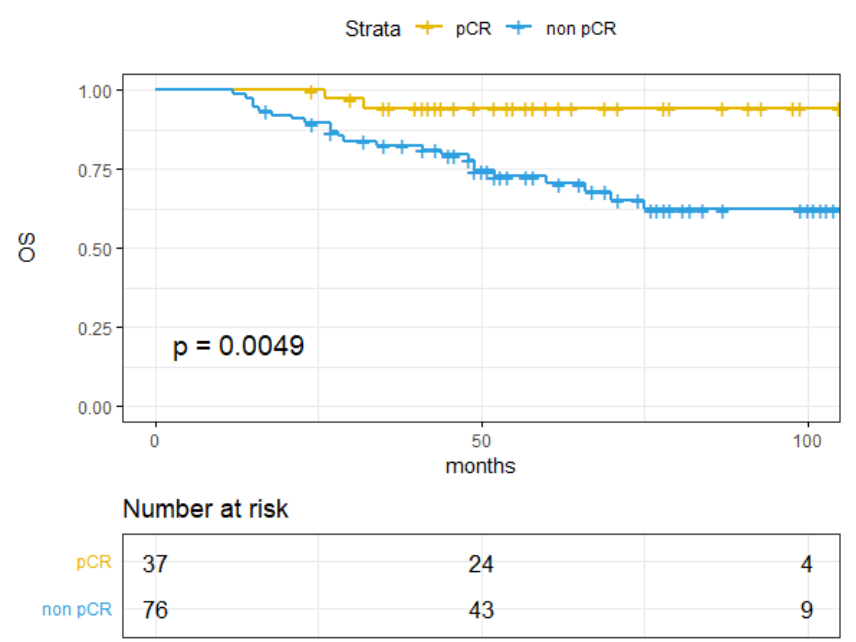
Figure A5. DFS in patients achieving pCR (5-y DFS: 91.2% [82.1–100%]) and those not achieving pCR (57.1% [46.6–70.0%]).